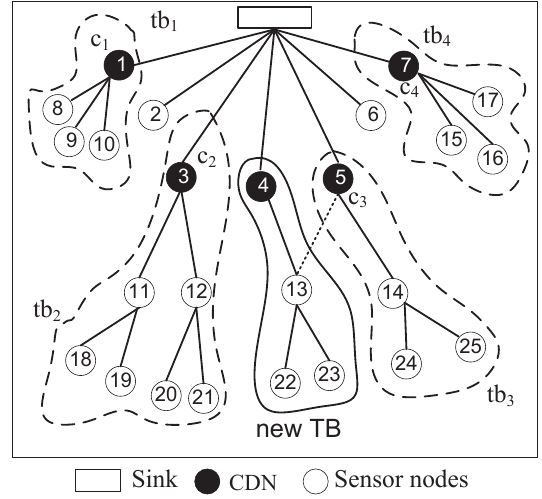
of Figure 1 into two 3